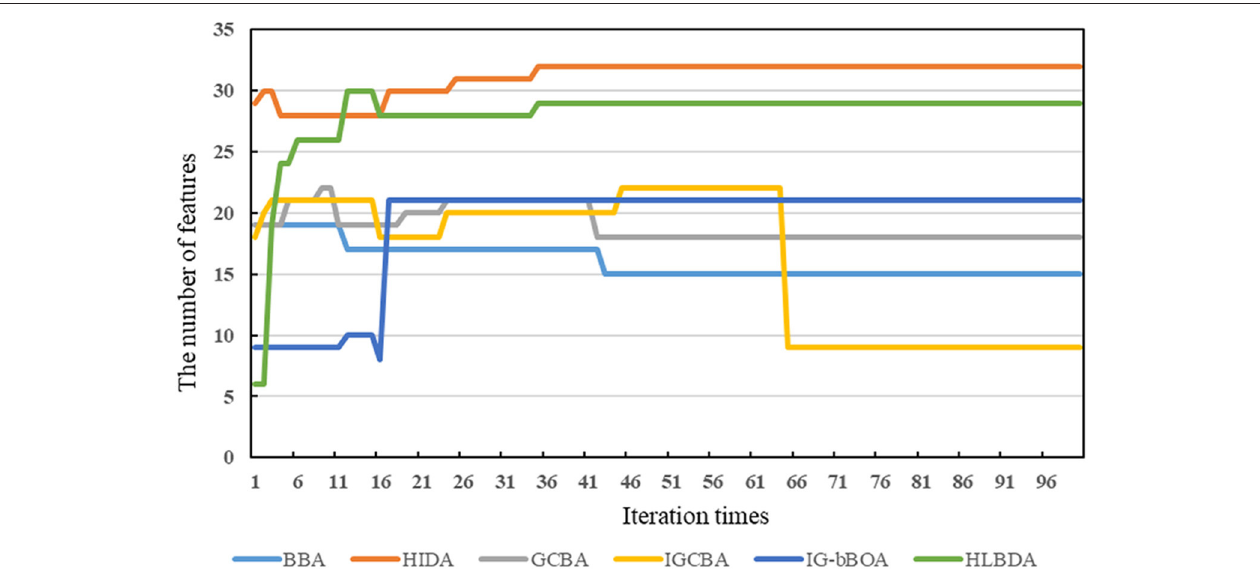
FIGURE 3 | The feature numbers curves of the six algorithms on the survey